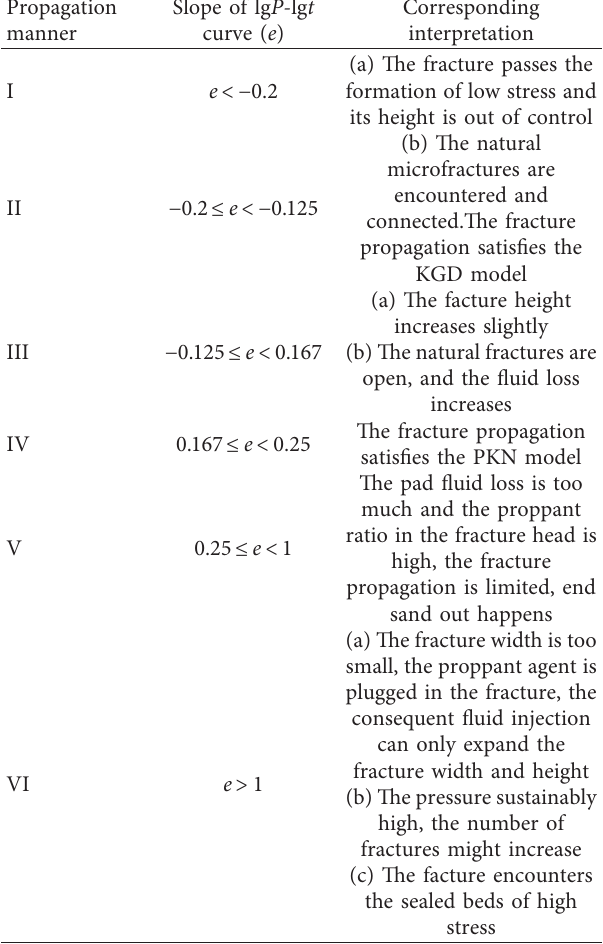
Table 1: The criterion of the fracture propagation manner according to the lg P -lg t